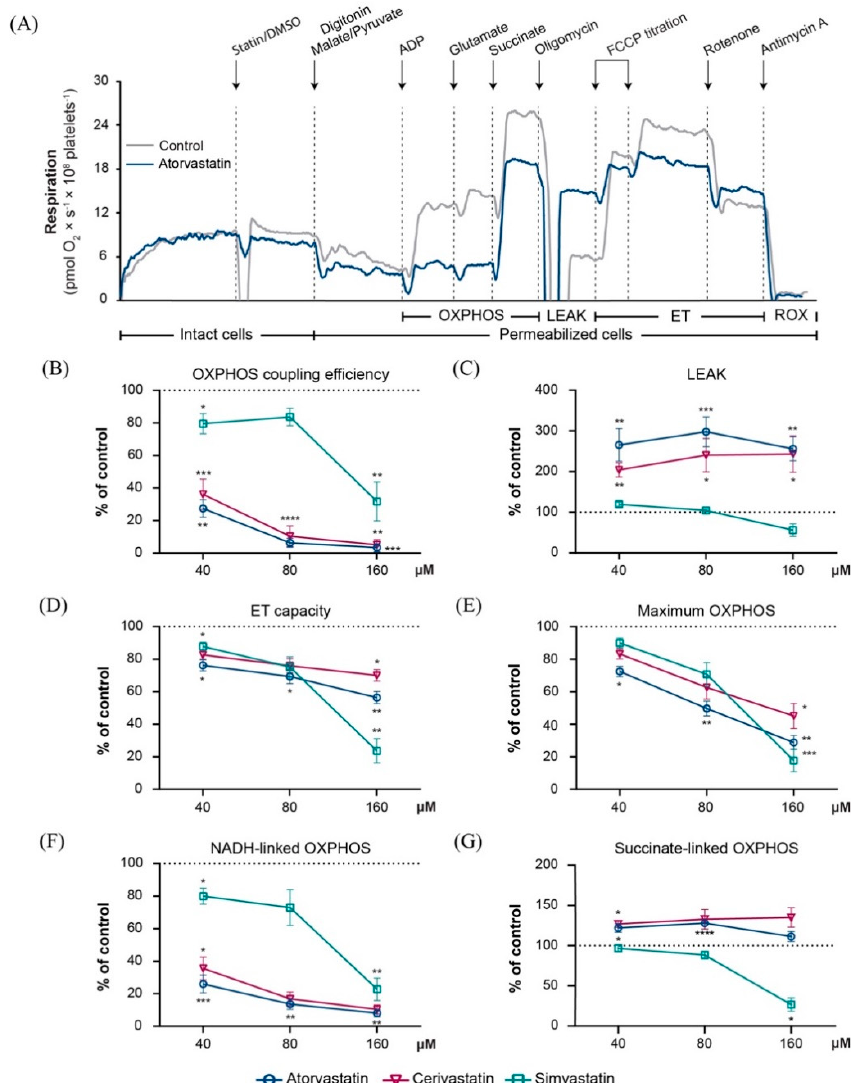
Figure 2. Statins induced a concentration − dependent inhibition of mitochondrial respiration in permeabilized human platelets. ( A ) Representative traces of atorvastatin 40 µ M (blue) and DMSO (grey). Concentration-dependent effects were assessed for 3 concentrations (40 µ M, 80 µ M and 160 µ M, respectively) of atorvastatin (open circle), cerivastatin (open triangle) and simvastatin (open square), respectively. OXPHOS coupling efficiency ( B ), LEAK ( C ), maximal ET capacity ( D ), maximal OXPHOS ( E ), NADH-linked OXPHOS ( F ), and succinate-linked OXPHOS ( G ) capacities were evaluated. Data is expressed as mean ± SEM of the percent of control (platelets exposed to the corresponding volume of DMSO for each of the 3 concentrations of statin). Two-way ANOVA with Bonferroni post hoc test was performed on antimycin-corrected data. DMSO, dimethyl sulfoxide; ET, electron transport; LEAK, non-phosphorylating resting stat; OXPHOS, oxidative phosphorylation; ROX, residual oxygen consumption. * p < 0.05; ** p < 0.01; *** p < 0.001; **** p < 0.0001 vs. DMSO. When examining the NADH (complex I) and succinate (complex II) pathways sepa- rately (Figure 2F,G), when applied in the lowest concentration (40 µ M), simvastatin elicited the mildest reduction in NADH-dependent OXPHOS (80% ± 5 of control) of the three statins. At the same concentration, both atorvastatin and cerivastatin significantly inhibited NADH-linked respiration (25.9% ± 6 and 35.5% ± 7 of control, respectively), and the inhibition was further augmented (respiration decreased) for the higher concentrations. Also, when applied in the highest concentration (160 µ M) simvastatin (but not